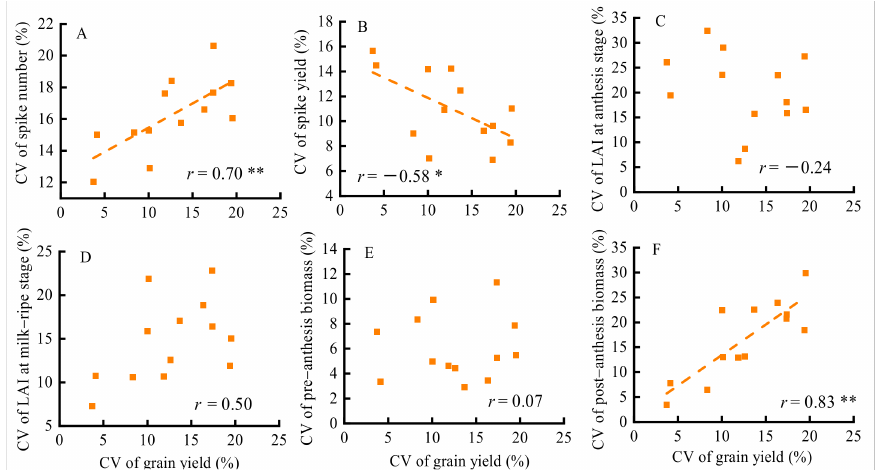
Figure 3. Correlations between the coefficient of variation (CV, %) of grain yield and the CV of ( A ) spike number, ( B ) spike yield, ( C ) leaf area index (LAI) at the anthesis stage, ( D ) LAI at the milk-ripe stage, ( E ) pre-anthesis biomass, and ( F ) post-anthesis biomass among cultivars. * p < 0.05; ** p < 0.01; ns,